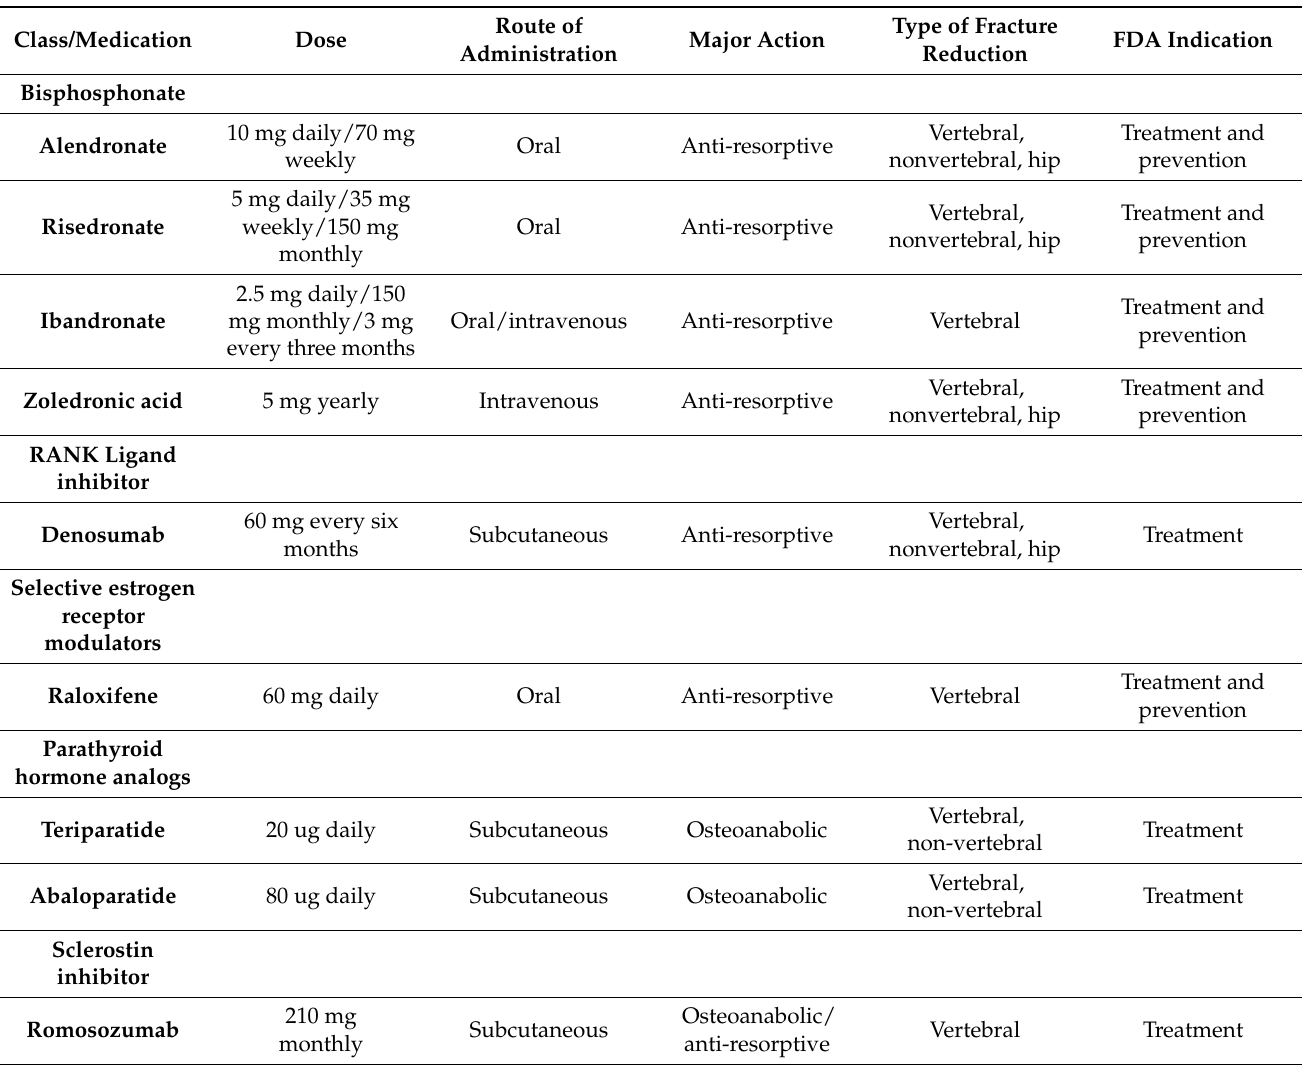
Table 2. Food and Drug Administration-Approved Pharmacological Interventions for Osteoporosis Treatment and Prevention.